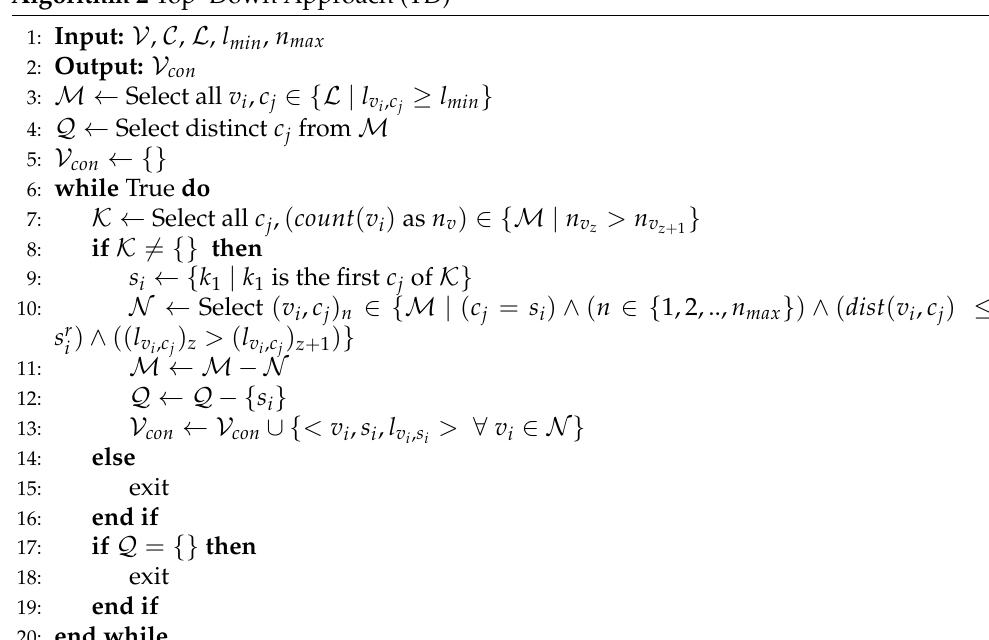
Algorithm 2 Top–Down Approach